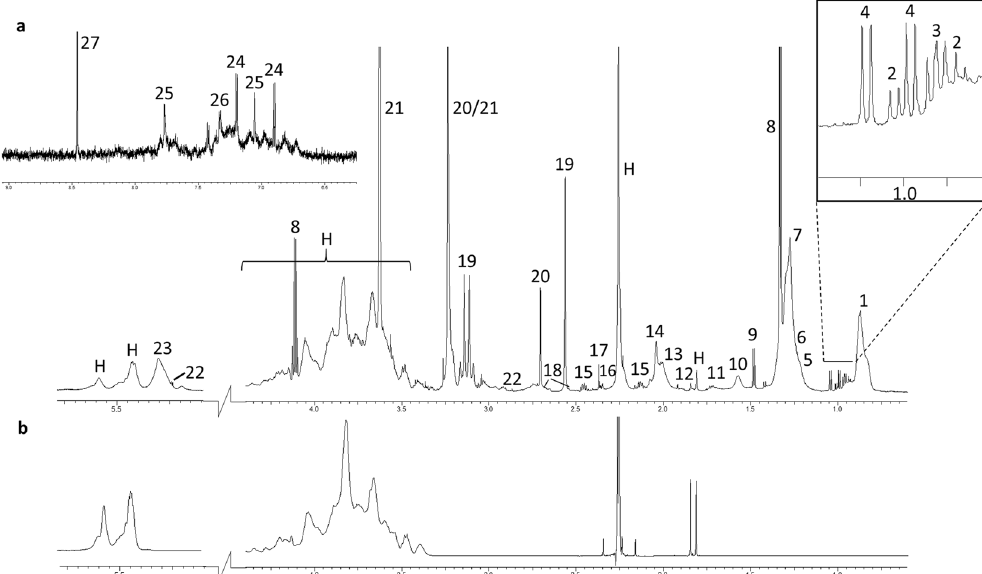
Figure 1. Representative 1 H CPMG NMR spectrum of ( a ) untreated NPC1 patient plasma with 27 major metabolites labelled; (1) mobile lipid -CH 3 , (2) isoleucine, (3) leucine, (4) valine, (5) 2,3 butanediol, (6) 3-hydroxybutyrate, (47) mobile lipid -(CH 2 ) n -, (8) lactate, (9) alanine, (10) mobile lipid –C H 2 CH 2 CO, (11) arginine, (12) acetate, (13) proline/mobile lipid CH 2 -C H 2 -CH = , (14) N-acetyl glycoprotein/mobile lipid CH 2 - C H 2 -CH = , (15) glutamate, (16) glutamine, (17) acetoacetate, (18) citrate,(19) Ca 2 + -EDTA, (20) Mg 2 + -EDTA, (21) EDTA, (22) Zn 2 + -EDTA, (22) α -glucose, (23) mobile unsaturated lipids > CH = CH < , (24) tyrosine, (25) histidine, (26) phenylalanine, (27) formate, and (H) contaminants arising from histopaque cell separation. ( b ) 1 H NMR spectrum of histopaque column flow through; matching contaminants are clearly visible in the plasma